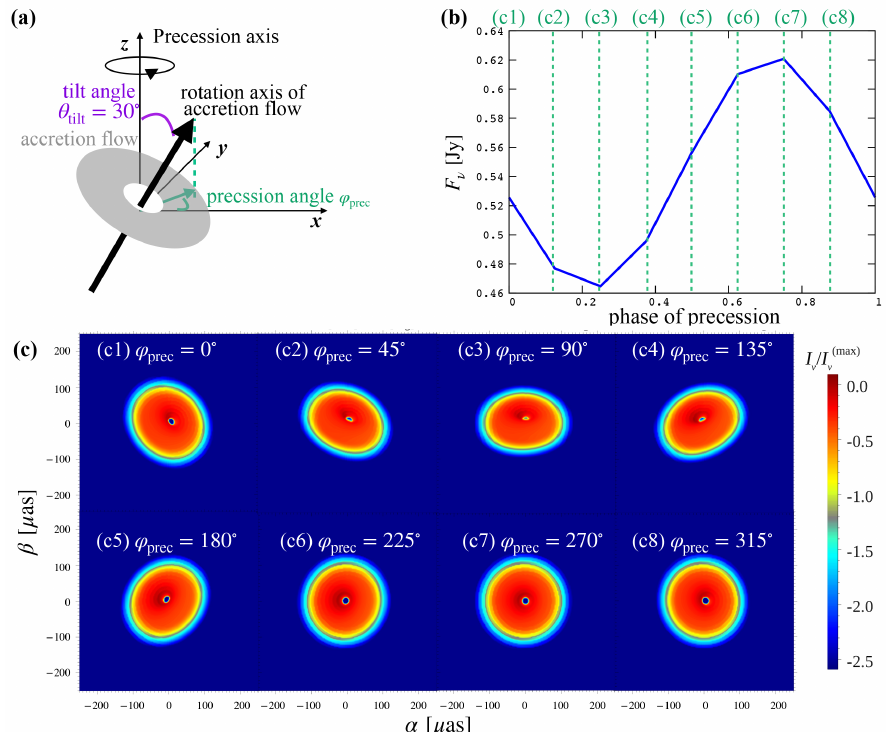
Figure 7. ( a ): Schematic picture of a precessing accretion flow. ( b ) Light curve. ( c ) GRRT images of precessing accretion flow. The tilt angle is set to be θ tilt = 30 ◦ . The precession angle ϕ prec is set (cid:112) x 2 + y 2 + z 2 , at every 45 ◦ from 0 ◦ to 315 ◦ . Here, the spherical coordinate is defined as cos θ ≡ z / (cid:112) (cid:112) x 2 + y 2 and sin φ ≡ y / x 2 + y 2 by using the Cartesian coordinate depicted in the cos φ ≡ x / panel ( a ). The observer locates in the direction ( θ ob , ϕ ob ) = ( 30 ◦ ,270 ◦ ) . We note that θ ob is the angle between the precession axis (not the rotation axis of accretion flow) and the line of